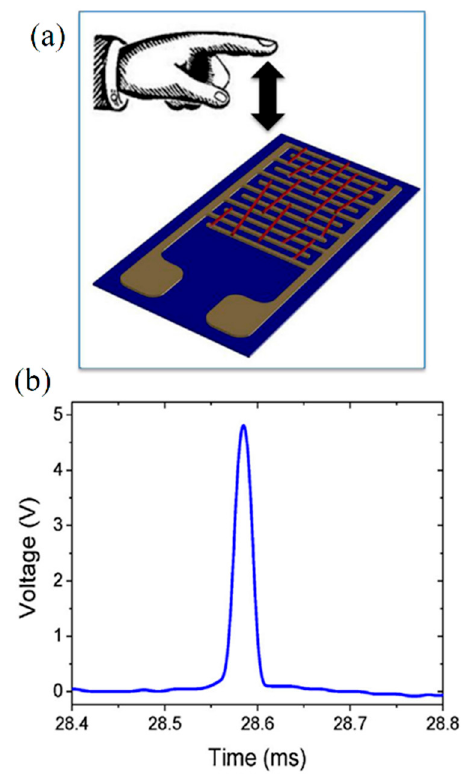
Figure 16. ( a ) Schematic of energy harvest examination by bending test; and ( b ) positive output voltage generated during a test performed with finger deformation for the PVDF electrospun NFs. Reprinted with permission from Ref. [93]. Copyright © 2013 Elsevier B.V.